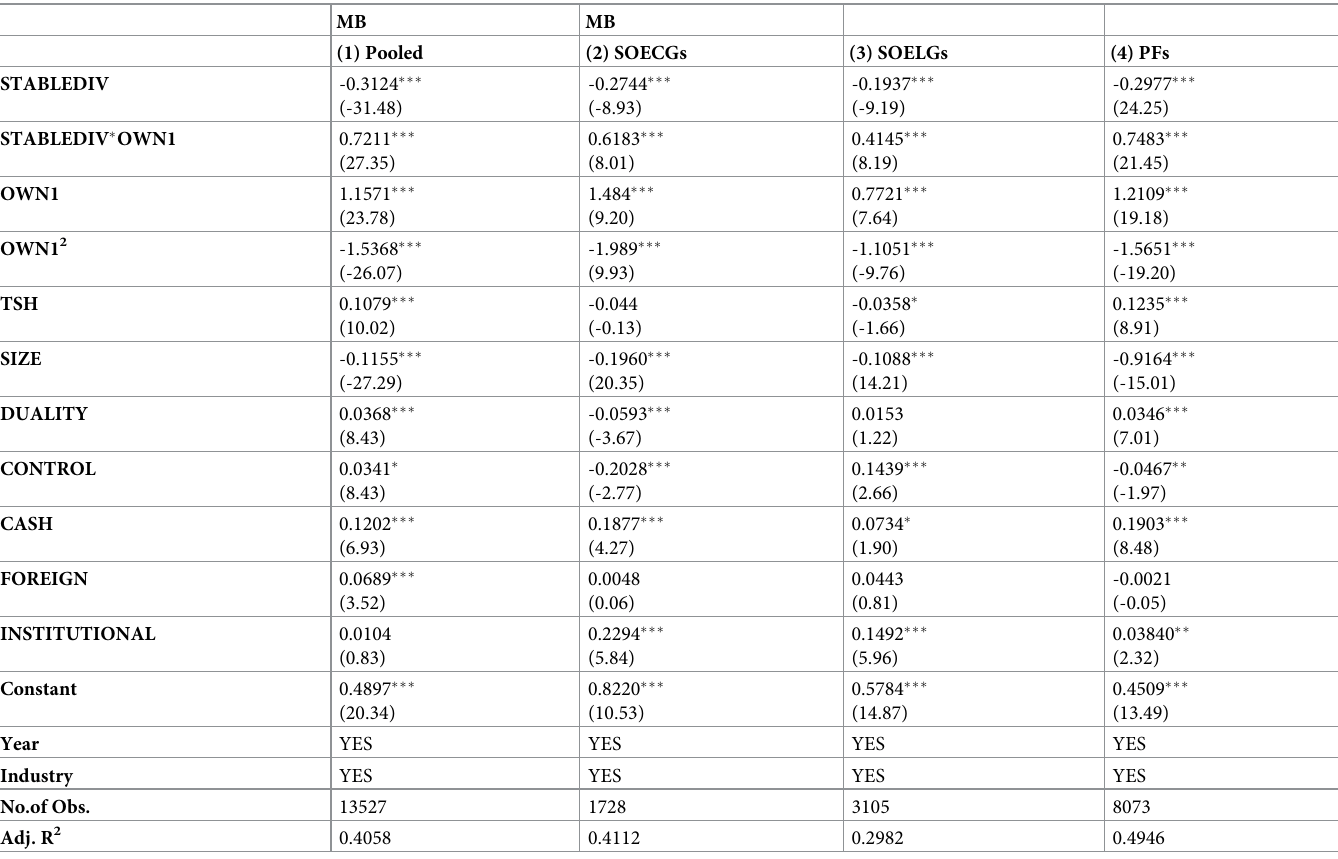
Table 10. Effect of stable cash dividend payout on the relation between ownership concentration and firm